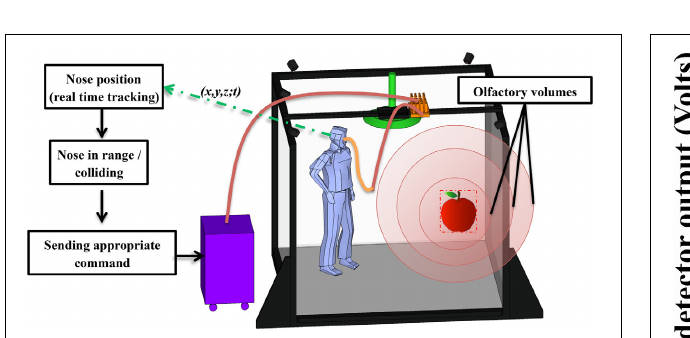
FIGURE 5 | Schema of the control protocol.